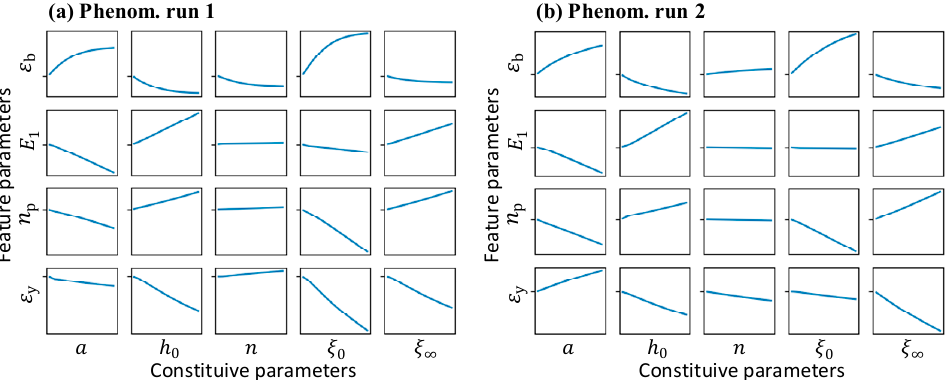
Figure 15. The integrated gradients for the BNN surrogate of the phenomenological CP model in ( a ) run 1 and ( b ) run 2